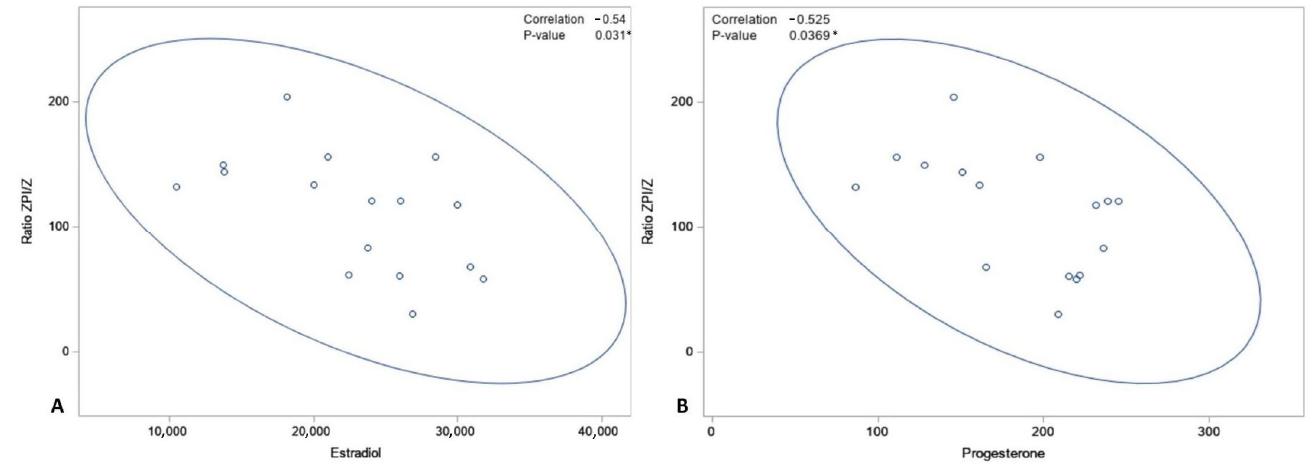
Figure 5. Pearson correlation test between ZPI/Z ratio in neonate and of the concentration of estradiol ( A ) and progesterone ( B ) in mothers, * p < 0.05.